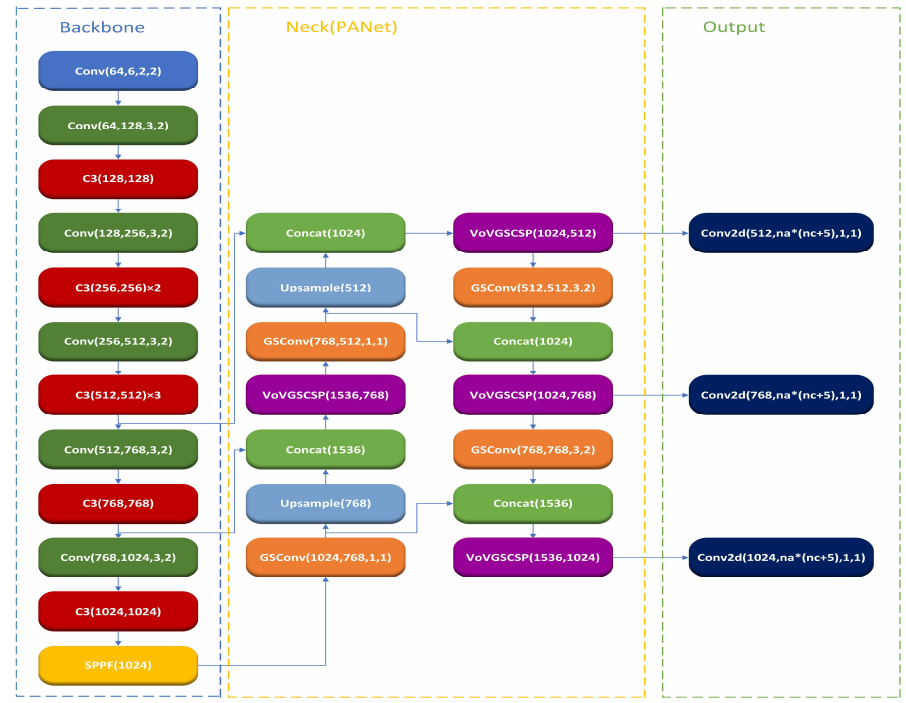
Figure 8. The network structure of the improved model in this paper.